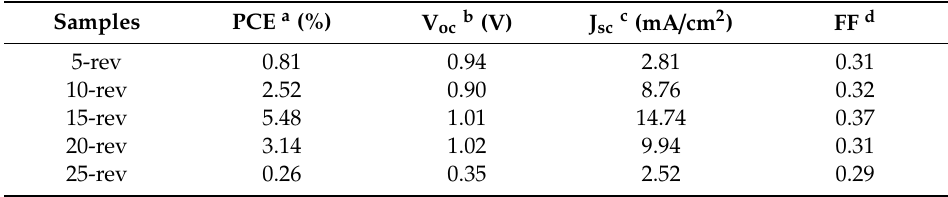
Table 2. Data extracted from reverse scanning J–V curves of perovskite solar cells optimized with di ff erent concentration of PC 61 BM. -rev represents reverse scanning. The number 5, 10, 15, 20, 25 represent di ff erent concentration of PC 61 BM. The device active area is 0.25 cm 2 (0.5 cm × 0.5